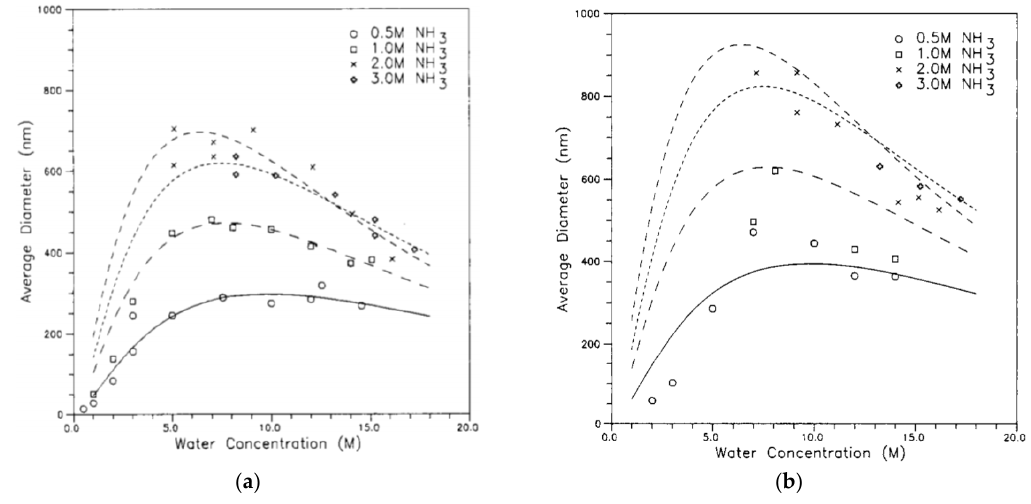
Figure 12. The relation between water content and average particle diameters at different ammonia concentrations at constant temperature and concentration of TEOS: ( a ) 0.17 M and ( b ) 0.3 M. Reprinted with permission from [51]. Copyright Elsevier, 1998.